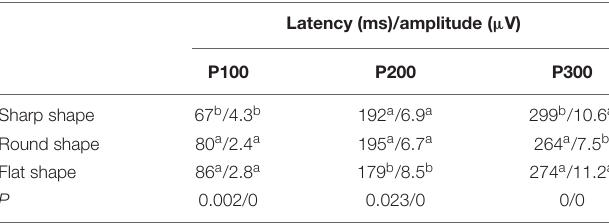
TABLE 3 | Summary of the latency and amplitude of ERP components.